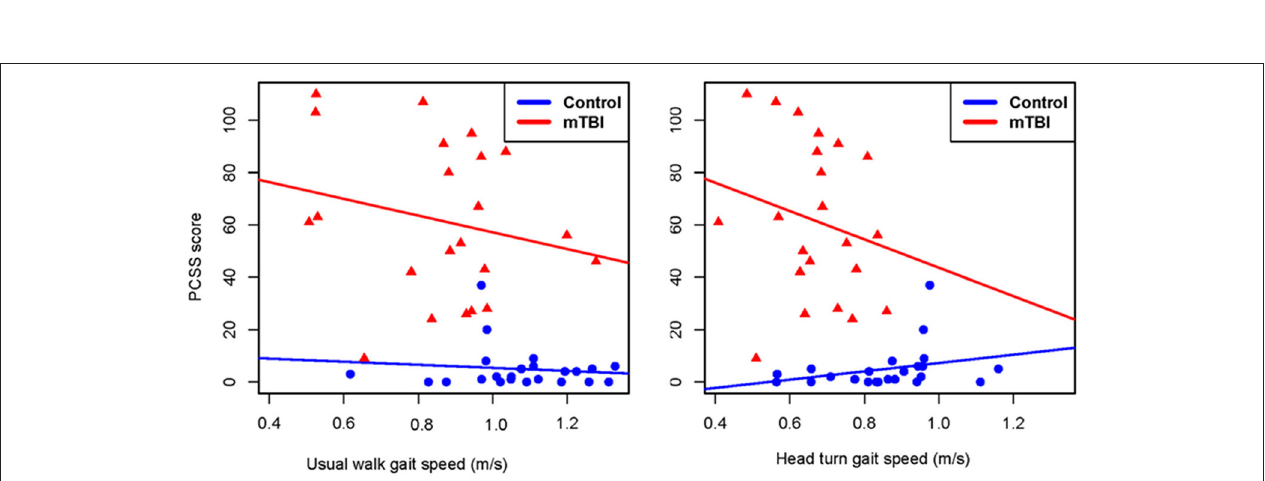
Frontiers in Neurology |